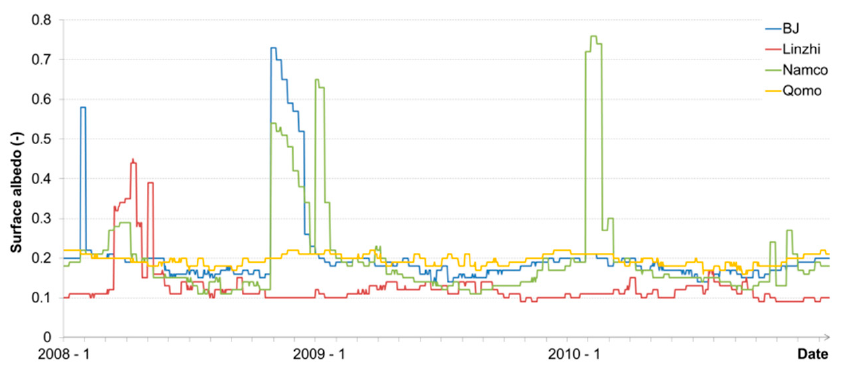
Figure 6. Time series of surface albedo derived from MODIS (MOD43B3) over the four ground stations used for the validation: BJ (blue), Linzhi (red), NamCo (green), and Qomolangma (yellow).